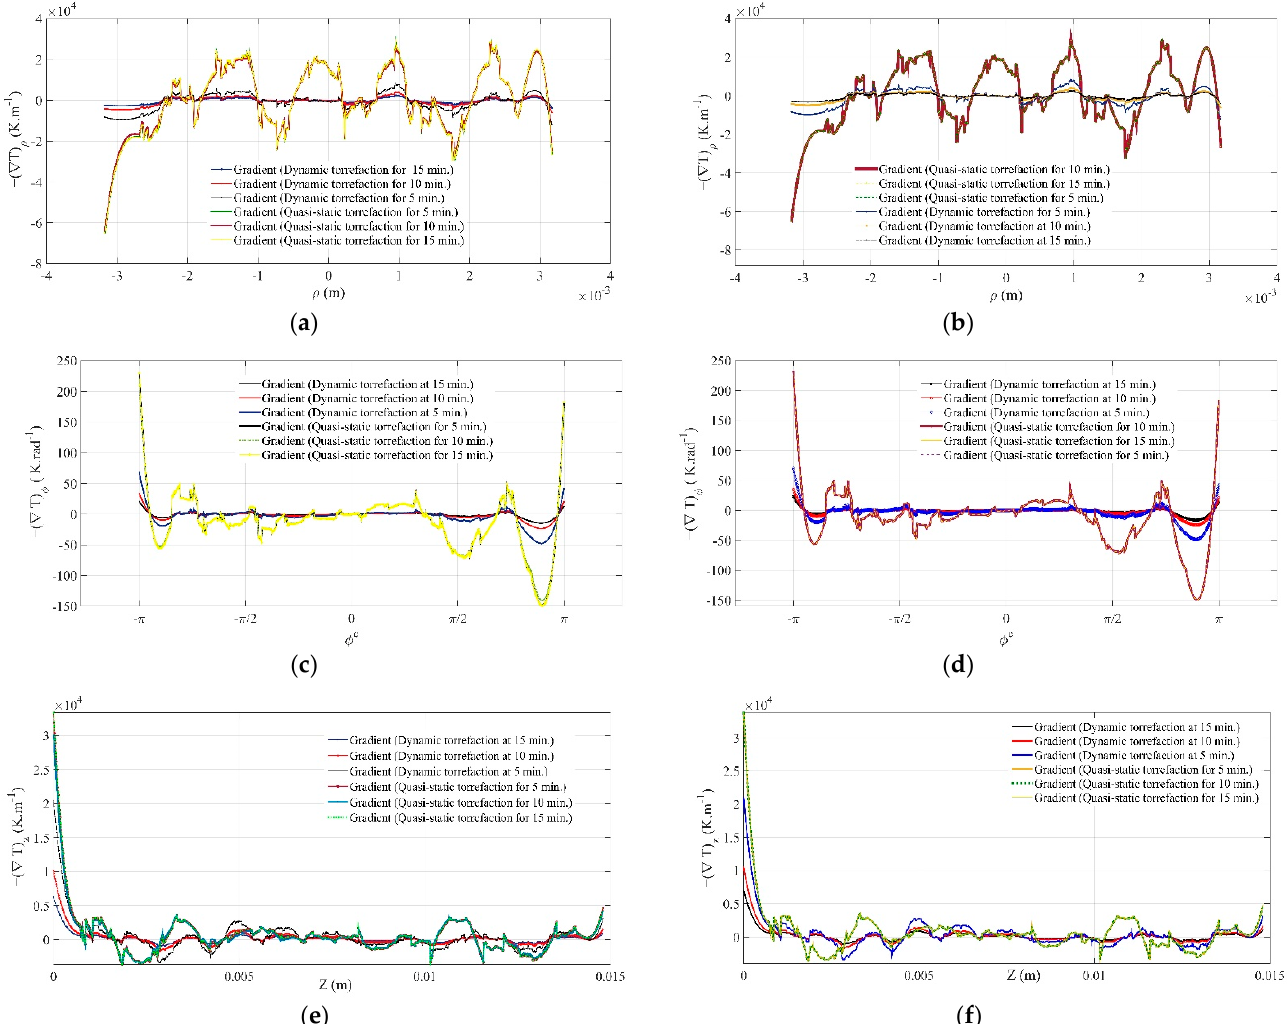
Figure 9. Thermal gradient in polar coordinate ( a , c , e ): varying heat flux, ( b , d , f ): constant heat flux. Unlike the gradual increase in the inward flow of heat flux along the radial axis, it